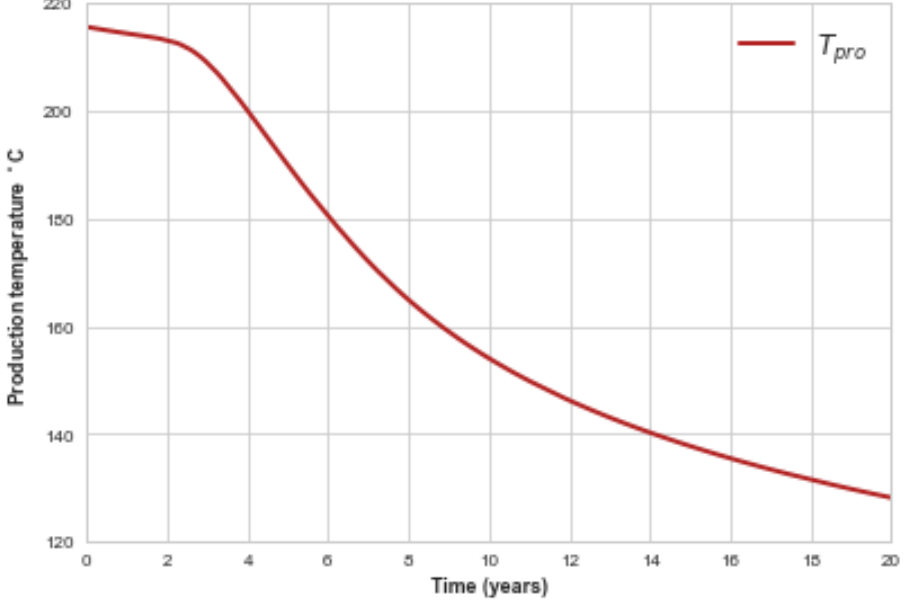
Figure 10. Production temperature decline curve over 20 years of simulation (reference case)